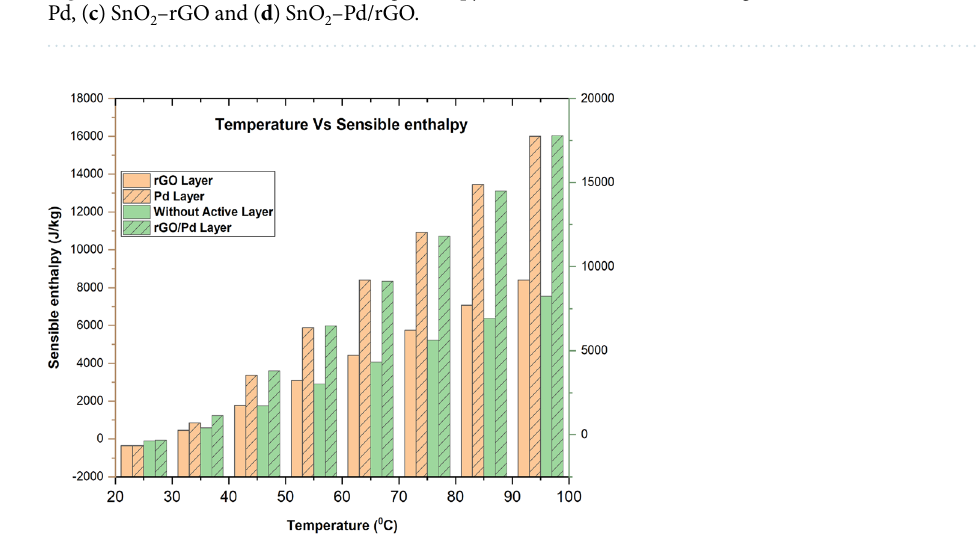
Figure 12. Sensor response of chemical gas sensors with/ without active layer towards NO x gas molecules in different working